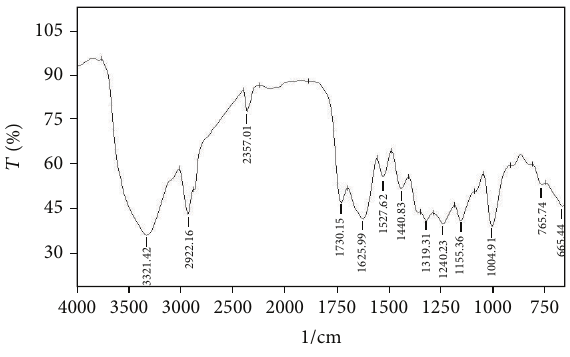
Figure 3: FT-IR spectrum of treated